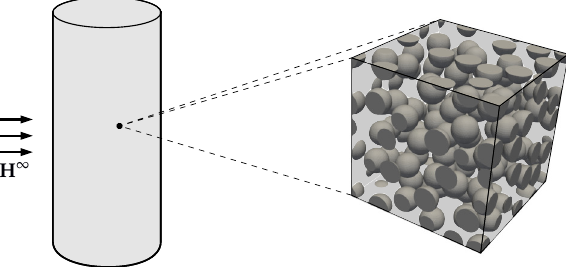
Figure 2. Illustration of an MAE sample: a macroscopic cylindrical sample in an external magnetic field H ∞ with an exemplary random microstructure at each material